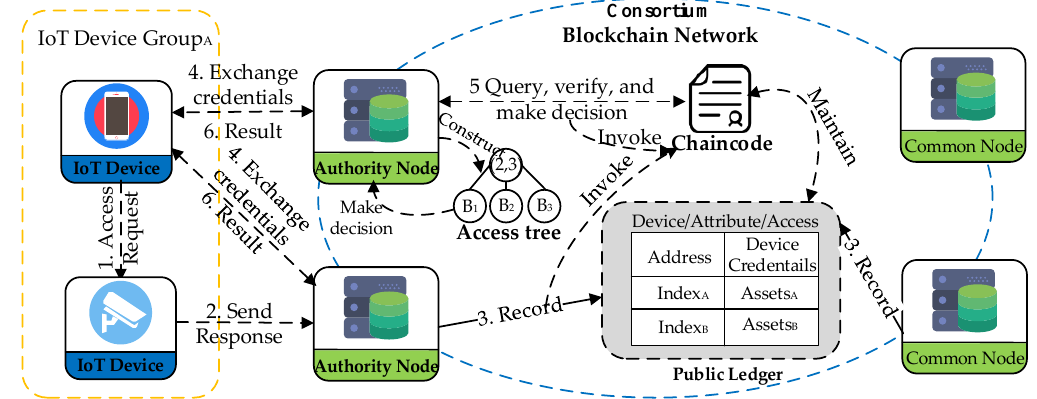
Figure 2. The architecture of the internet of things (IoT) system in which we implement our proposed access control